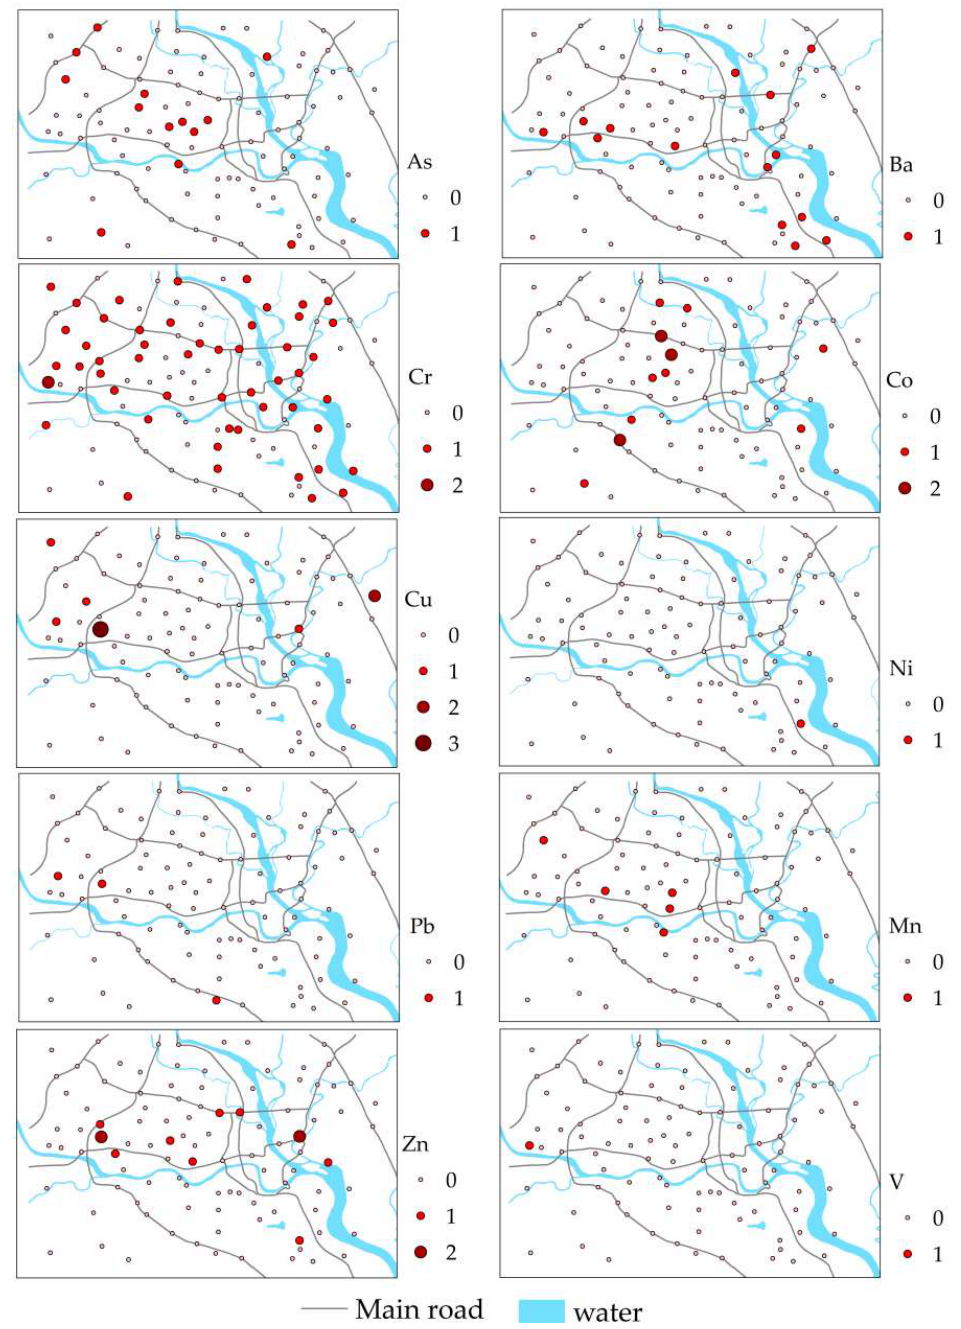
Figure 3. The I geo level of HMs in Mianyang urban area.